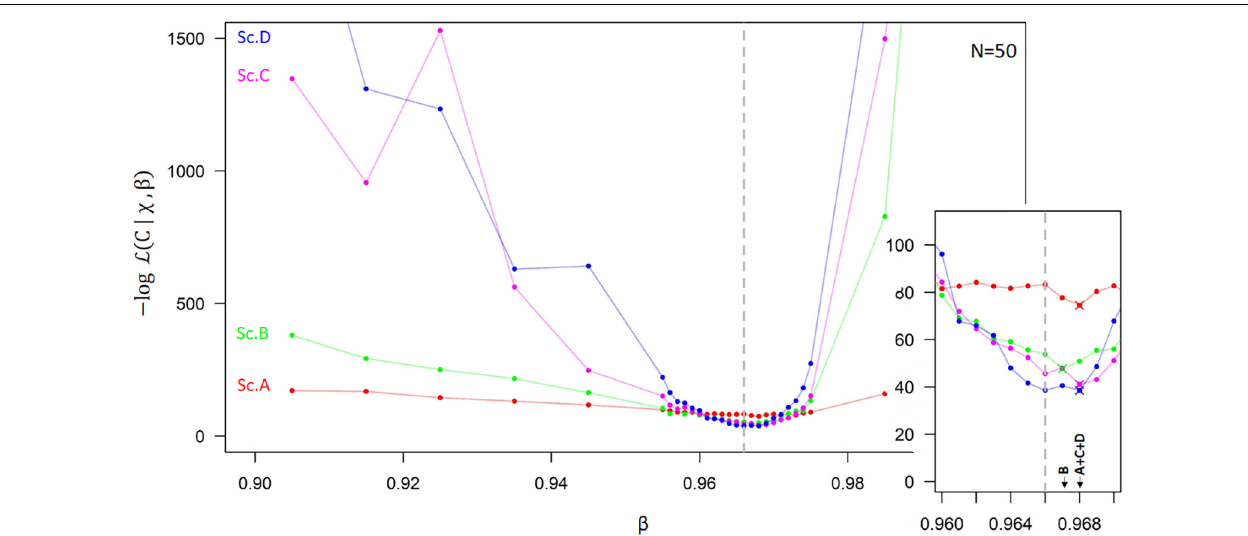
FIGURE 2 | Example of a Log-likelihood curve (–log L ( β (cid:12) (cid:12) C , χ ) ) as a function of the allocation parameter β which defines the exponential vertical decay of the distribution of absorbing root surface with soil depth, under four different scenarios (Sc. A–D). The best β estimate ( b β ) , has the minimal log-likelihood values shown for each scenario in a magnified panel (the true β is indicated by the dashed line, β true = 0.966). This figure represents a sample size ( N ) of 50 individuals. Supplementary Figures 2A,B shows similar likelihood profiles for smaller sample sizes. Sc. A: No restrictions are considered. Sc. B: Restriction imposed on the physical variables, i.e., the soil heterogeneity. Sc. C: Restriction of both the physical variables and the sampling strategy. Sc. D: Full restriction, thus considering an additional restriction on the biological plant-specific variables. More details in the main text and the applied parameter restriction for each scenario are given in Supplementary Table 2 and Table 1